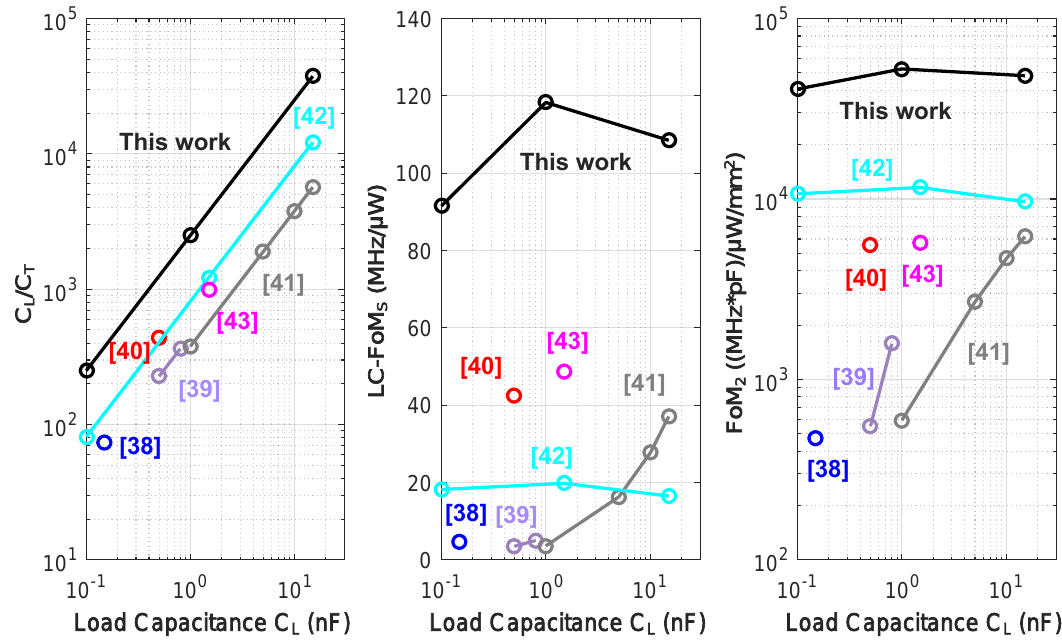
Figure 21. Benchmark of C L / C T , LC-FoM s and FoM 2